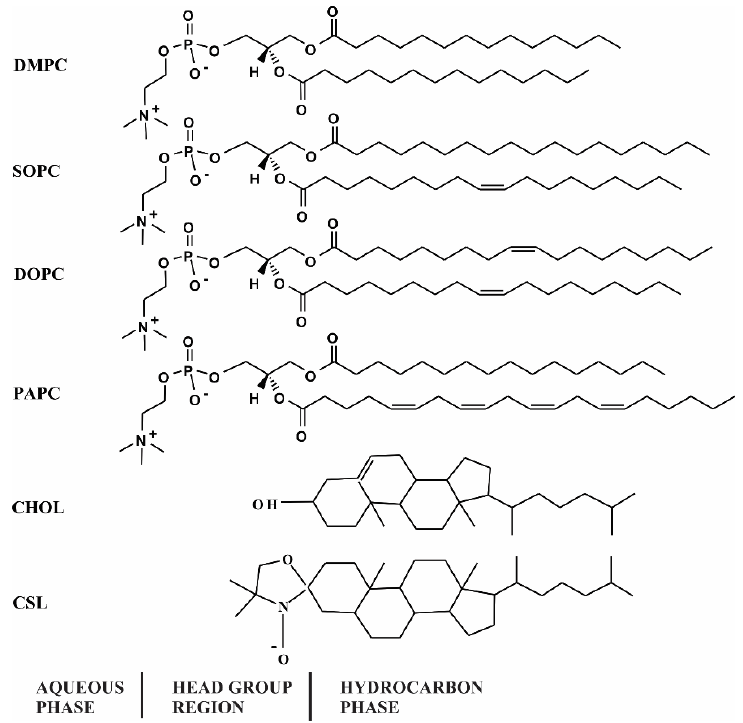
Figure 1. The chemical structures of 14:0 − 14:0 PC (DMPC), 18:0 − 18:1 PC (SOPC), 18:1 − 18:1 PC (DOPC), 16:0 − 20:4 PC (PAPC), cholesterol (Chol), and cholesterol analogue spin-label (CSL). Approximate locations of each molecule across the lipid bilayer membrane are indicated. The nitroxide moiety of the CSL spin-label resides near the headgroup region.